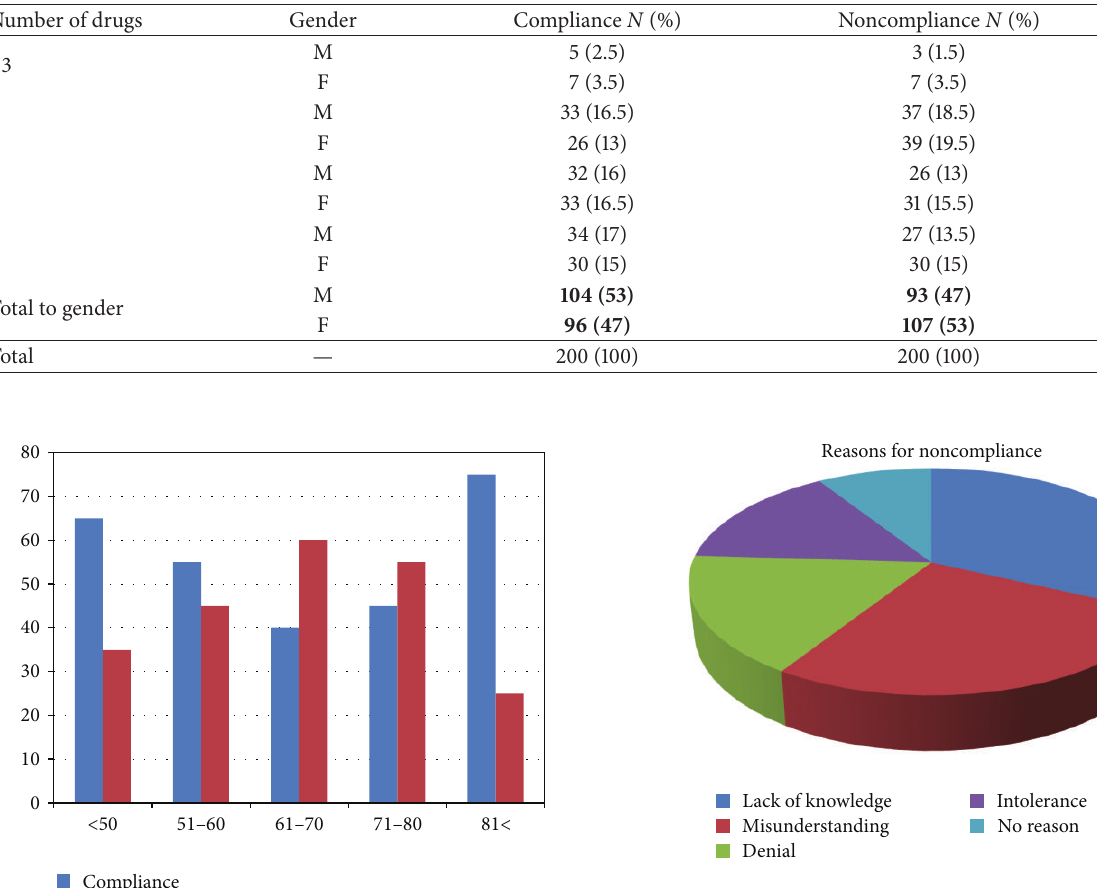
Figure 3: Reasons for noncompliance represented in 5